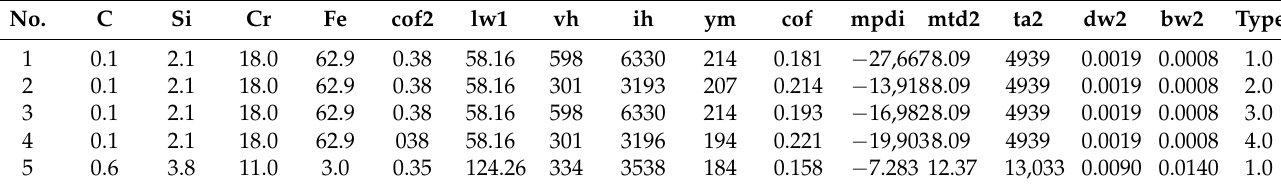
Table 5. Five elements of the set for fluid friction with the added means.